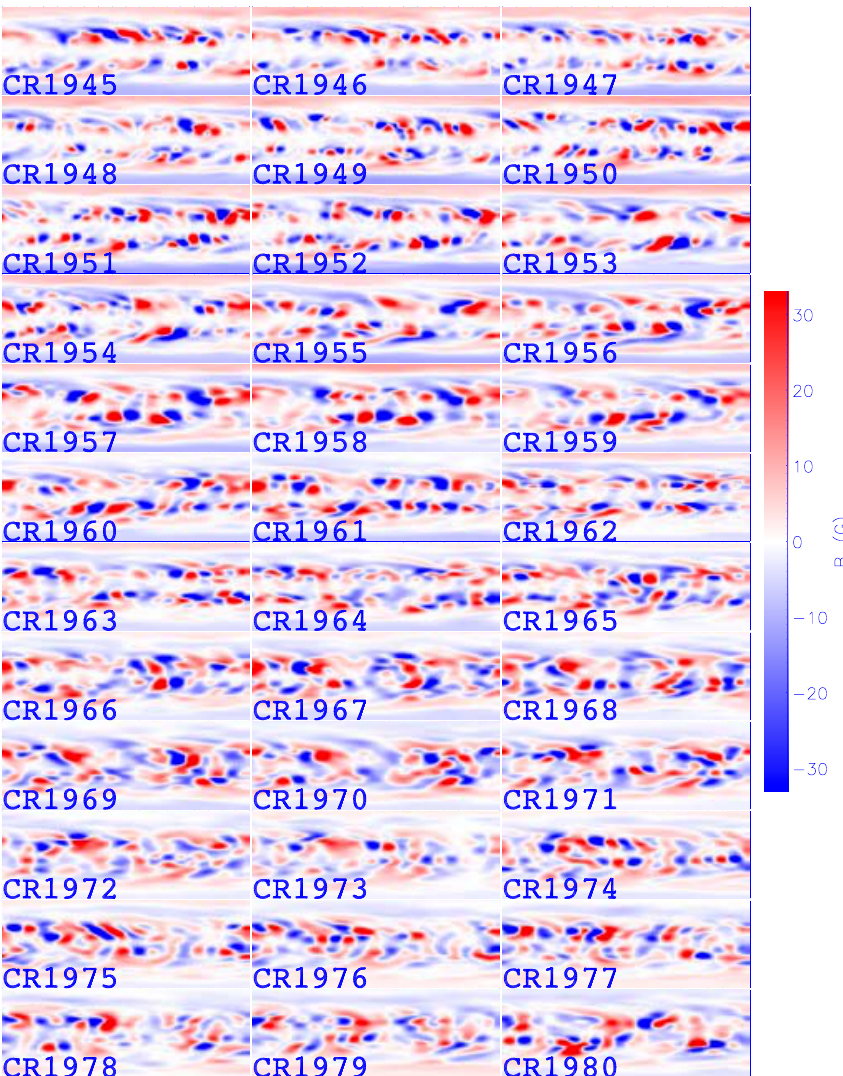
Fig. 2. Radial magnetic field at the photosphere for CR1945 to CR1980, derived from Kitt Peak synoptic